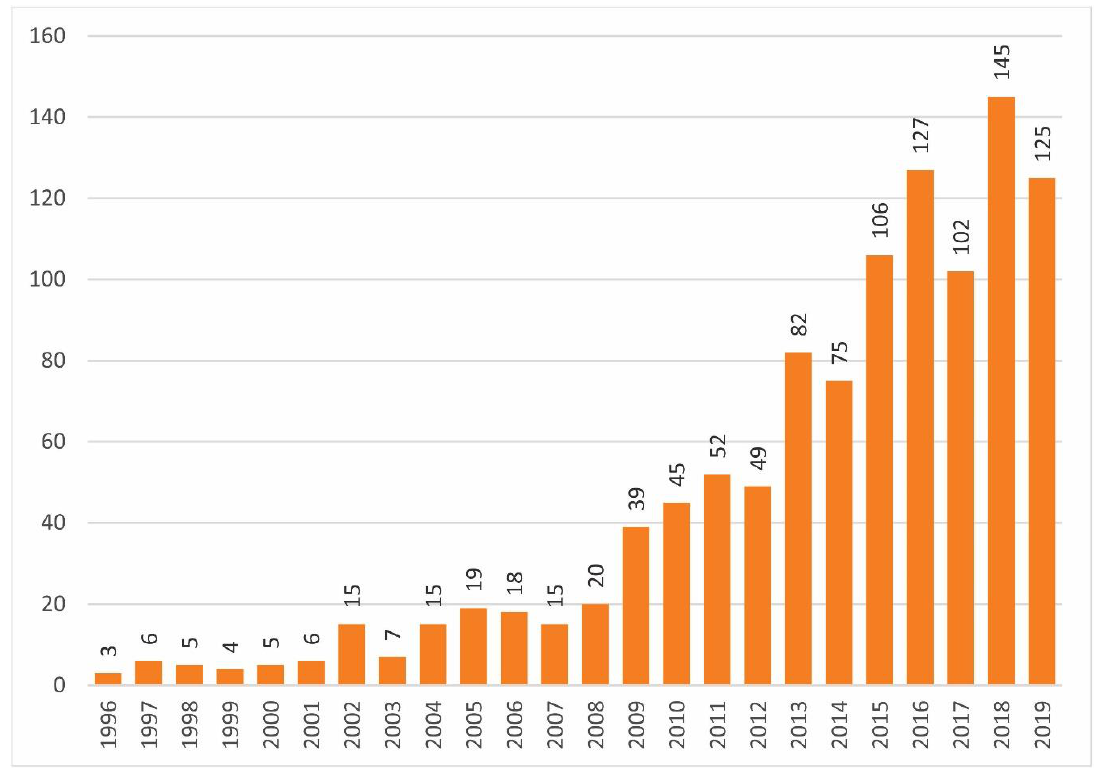
Figure 3. Bar chart of the time evolution of scientific/technical publications (records) on uncertainties in FRA in the WOS database (search: “flood” AND “risk” AND “assessment” AND “uncertainty*”), from 1996 to 2019 [5].